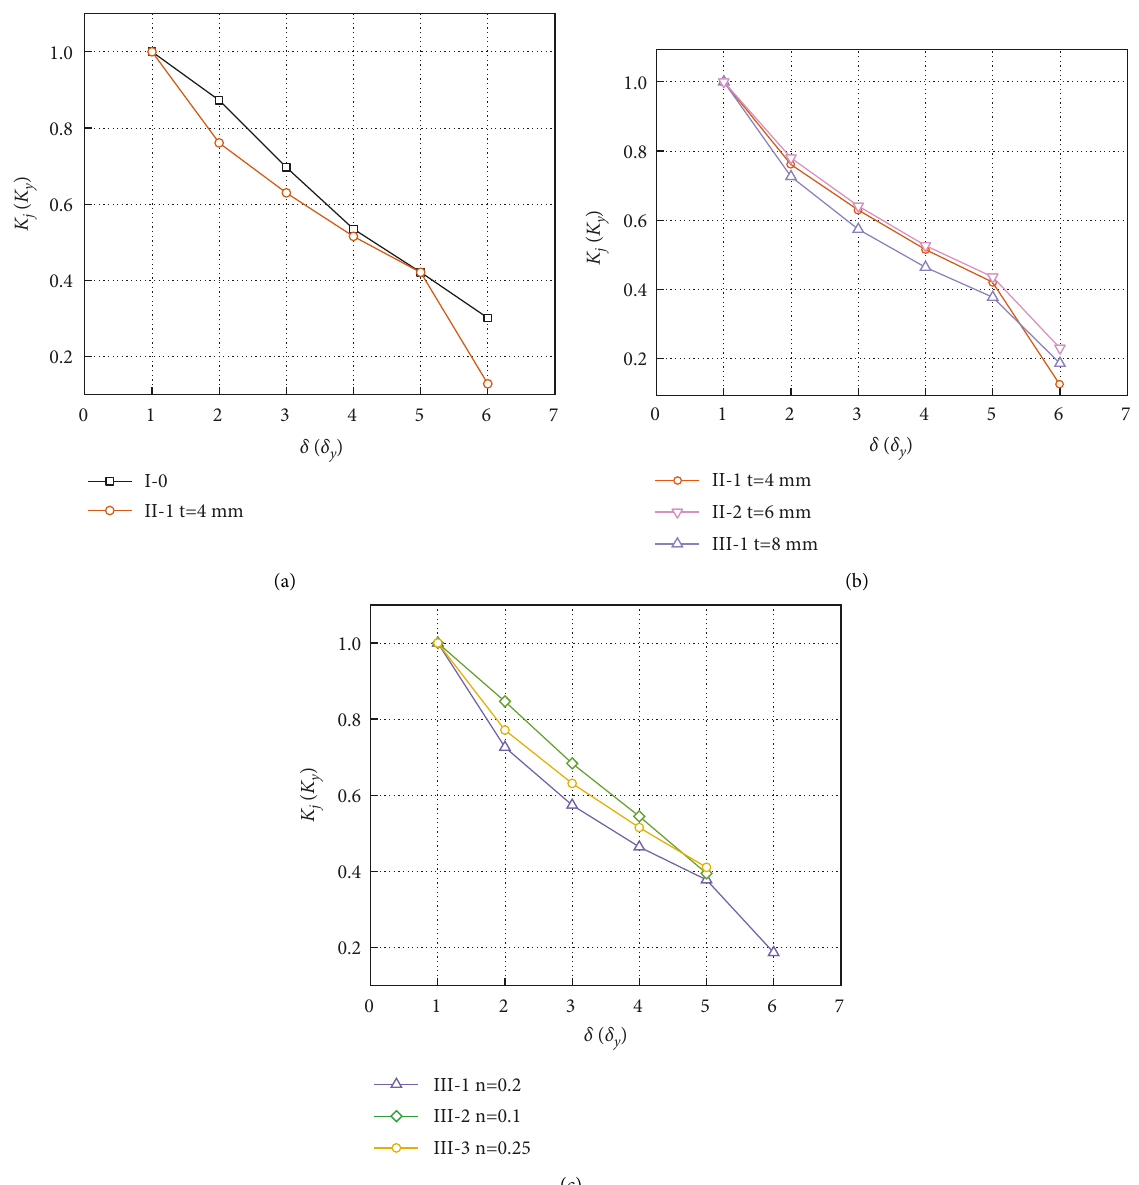
Figure 15: Stiffness degradation of typical specimens. (a) Impacts of energy-dissipating plates. (b) Impacts of the thickness of energy- dissipating plates. (c) Impacts of axial compression